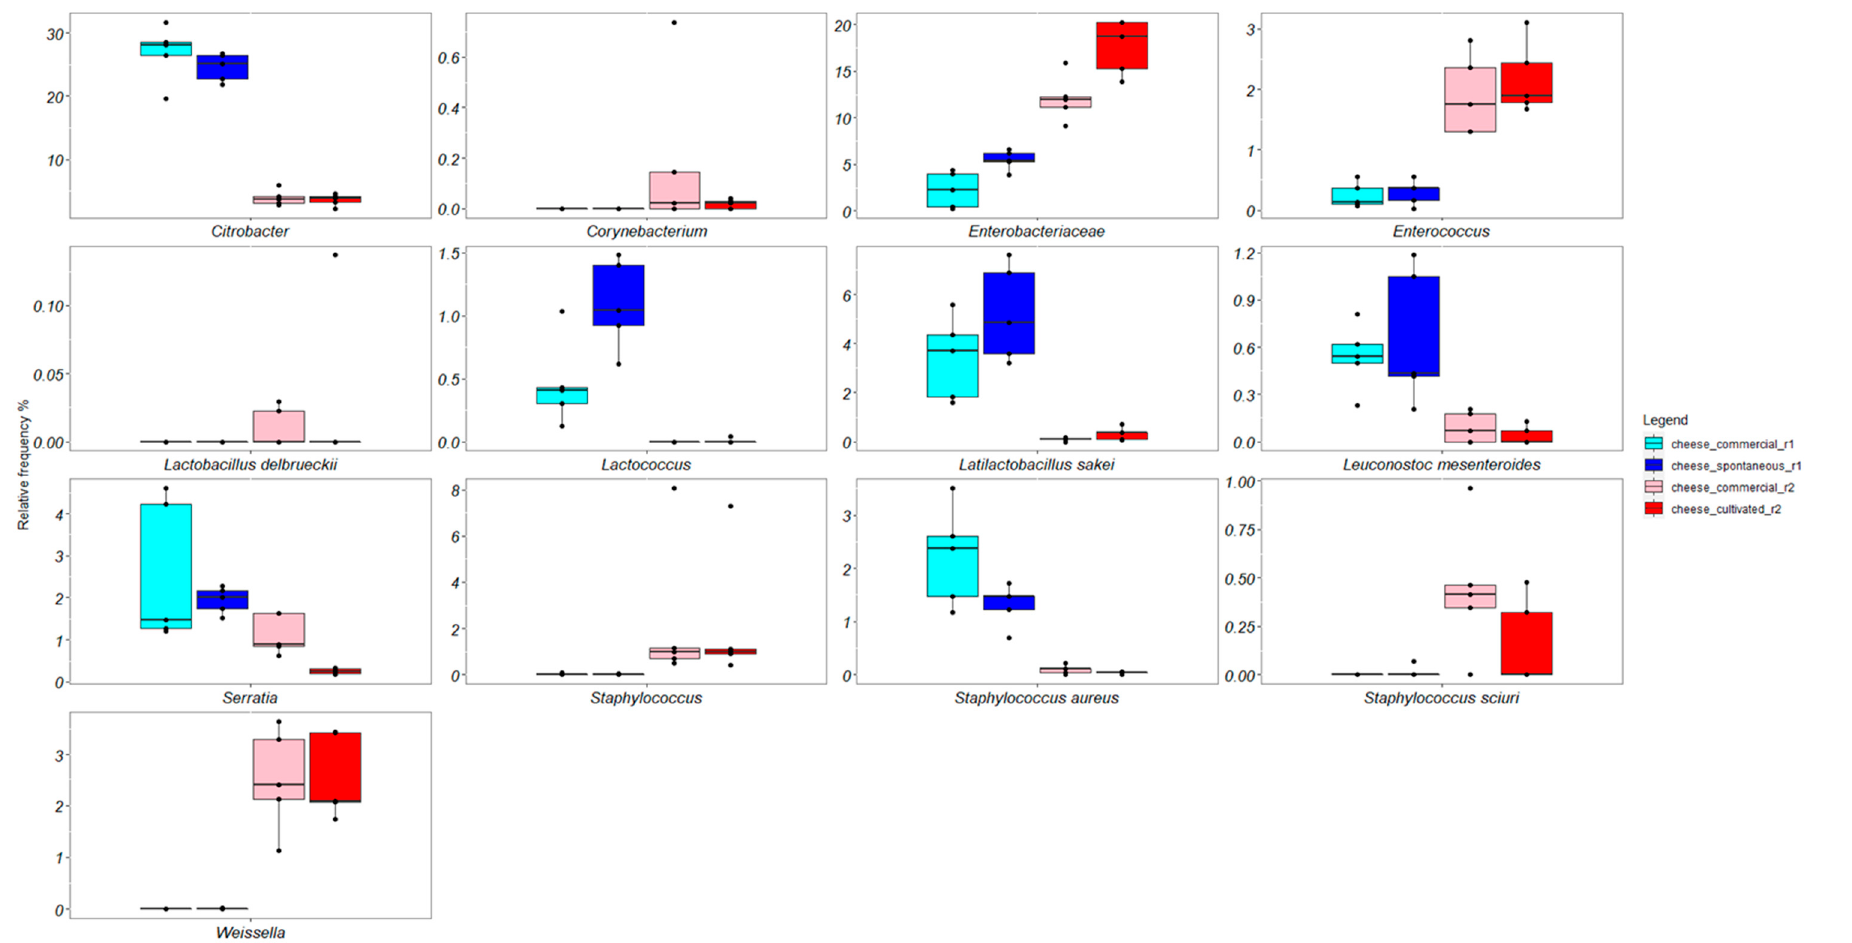
Figure 6. Boxplots showing relative frequencies of bacterial differential ASVs evaluated through the Kruskal–Wallis test ( p -value < 0.05) in experimental Caciofiore cheeses.